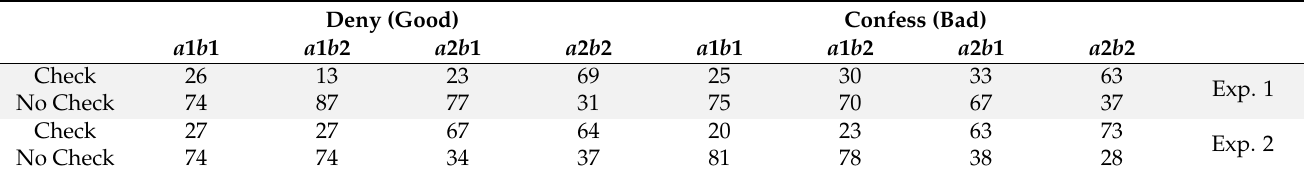
Table 3. Frequencies of checking for each question combination.